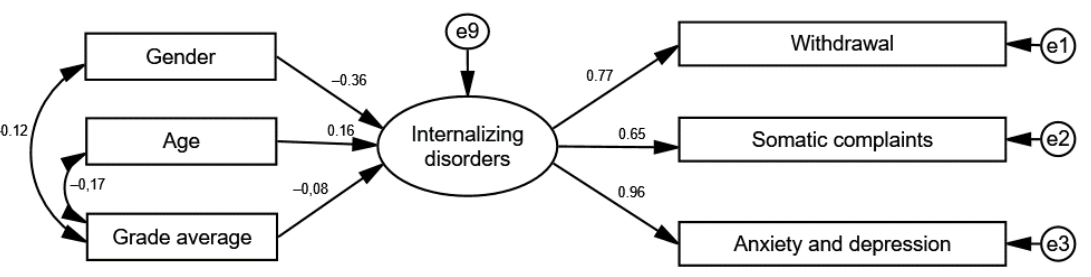
Figure 3. Standardized regression coefficients for the model of relationships between gender, age, and grade average and internalizing behaviors.